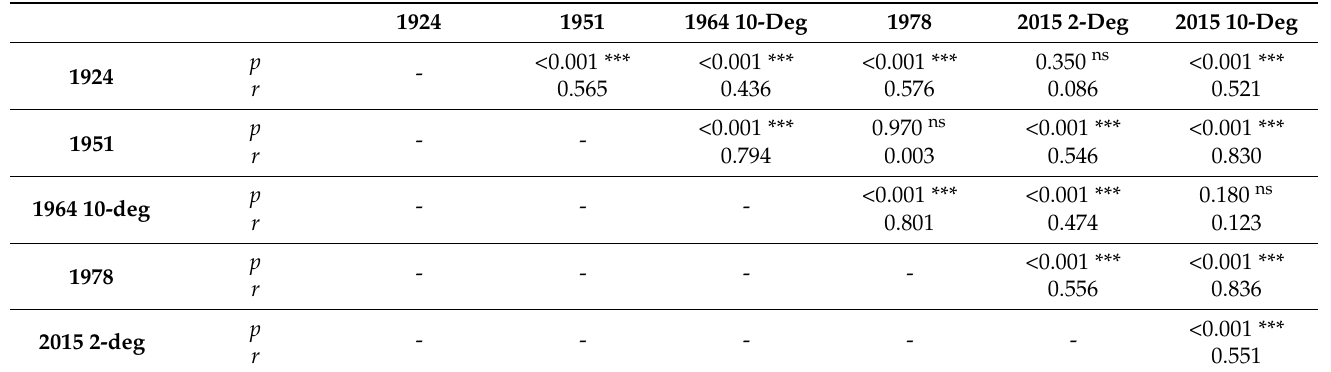
Table 8. Rank sum test and effect size for D uv ( p -value and effect size ( r